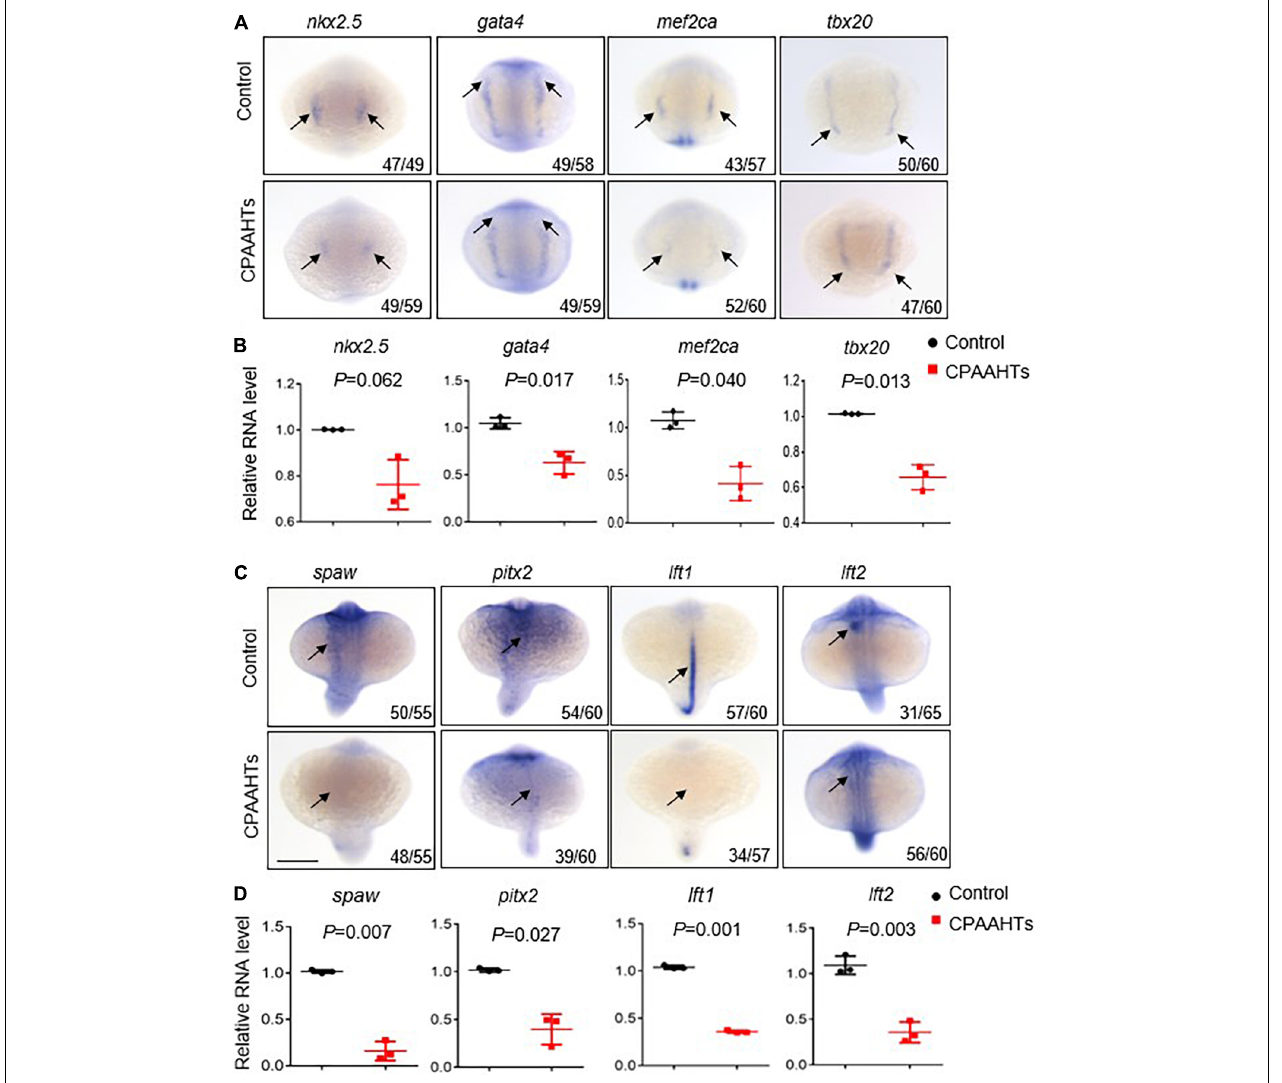
FIGURE 4 | CPAAHTs exposure suppressed the expression of genes required for myocardium differentiation and LR asymmetry. (A,B) Dorsal view of WISH images (A) and quantitative RT-PCR analysis (B) of transcription factors nkx2.5, gata4, mef2ca, and tbx20 in 0.8 µ g/ µ l CPAAHTs treated embryos compared with untreated controls at 8-somite stage (SS). Arrows point to expected expression patterns for the corresponding genes. N = 3. Unpaired 2-tailed Student’s t -test. (C,D) Dorsal view of WISH images (C) and quantitative RT-PCR analysis (D) of Nodal-related gene spaw and its downstream target genes in 0.8 µ g/ µ l CPAAHTs treated embryos compared with untreated controls at 25- to 28-SS. Arrows point to the expected expression patterns for the corresponding genes. N = 3. Unpaired 2-tailed Student’s t